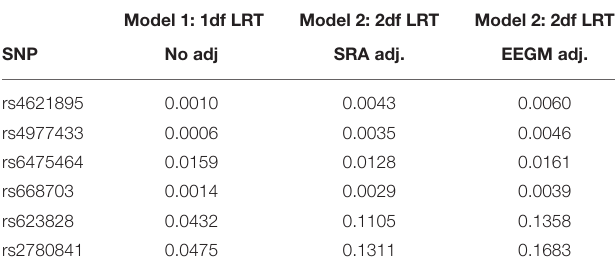
TABLE 3 | P -values of 1 df likelihood ratio test from Model (1), and 2 df likelihood ratio tests from models with SRA and EEGM adjustment for the 6 SNPs in the MLLT3 gene on chromosome 9 show significant evidence of interaction with Maternal Alcohol Consumption.